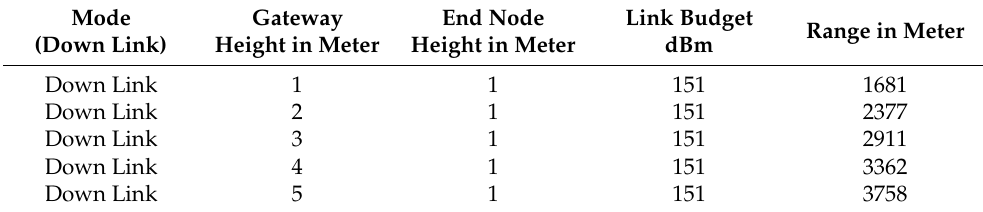
Table 6. Range and link budget at node sensitivity of − 137